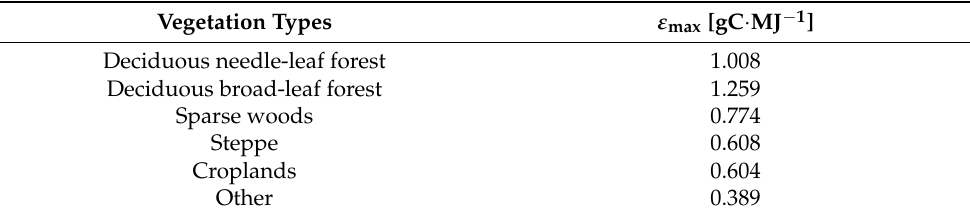
Table 3. Maximum light use efficiency of different vegetation